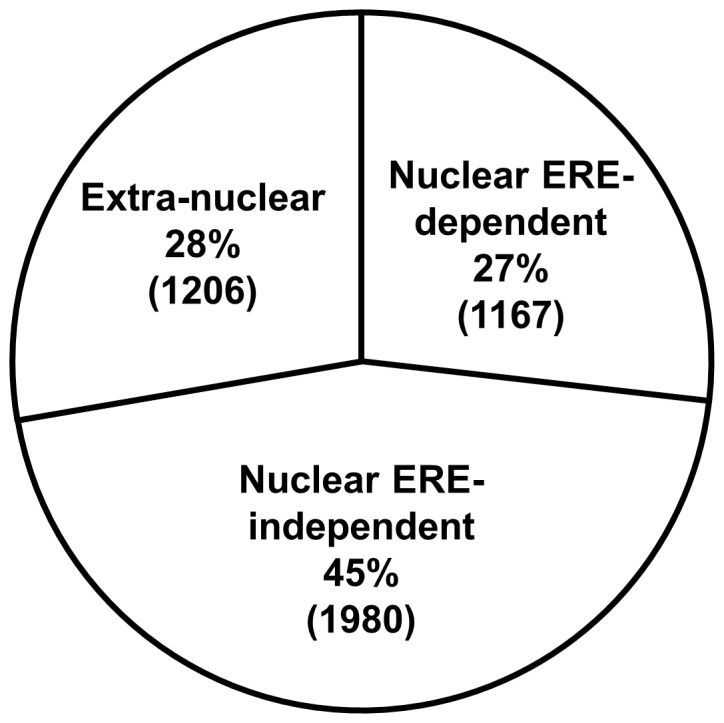
Confirmation of the RNAseq datasets and percentage breakdown of all estrogen-regulated genes among the three modes of ERα action.Breakdown of all the estrogen-regulated genes in the RNAseq analysis among the modes of ERα action, showing percentages and the number of genes from each mode in parentheses.